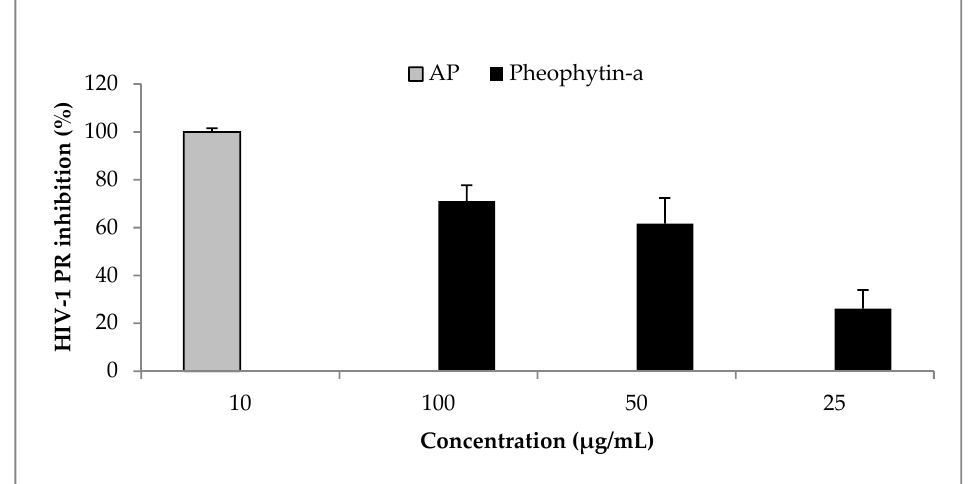
Figure 3. Effect of phy-a on HIV-1 PR. Phy-a, fluorogenic substrate and HIV-1 PR were incubated at 37 °C for 1 h. Phy-a significantly ( p < 0.05) inhibited HIV-1 PR with >50% inhibition at 50 and 100 μ g/mL. The estimated IC 50 value was 44.4 ± 1.5 μ g/mL (51 ± 1.7 μ M). Acetyl pepstatin (AP) a known protease inhibitor was used as control 10 μ g/mL = 15.5 μ M.